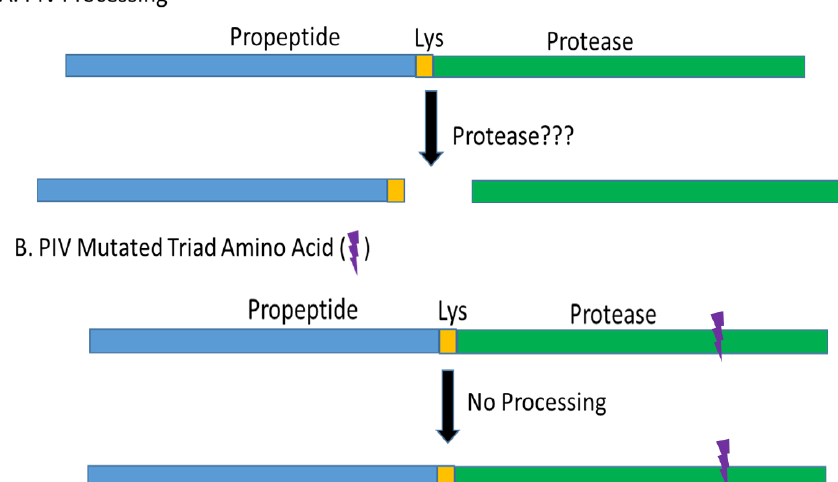
Figure 1. Processing of PIV. ( A ) This represents the process known to occur and emphasizes that the protease responsible for cleavage of the mature protease from the propeptide is not yet fully established. ( B ) This illustration demonstrates that a PIV molecule with a mutated catalytic residue is unable to be processed; this finding was obtained in strain PA103-29, an organism that lacks production of LasB [47].